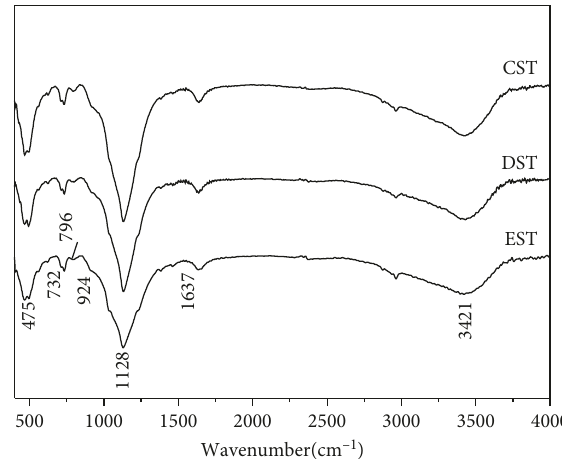
Figure 14: FTIR spectra of the PAG-solidified CST, DST, and EST